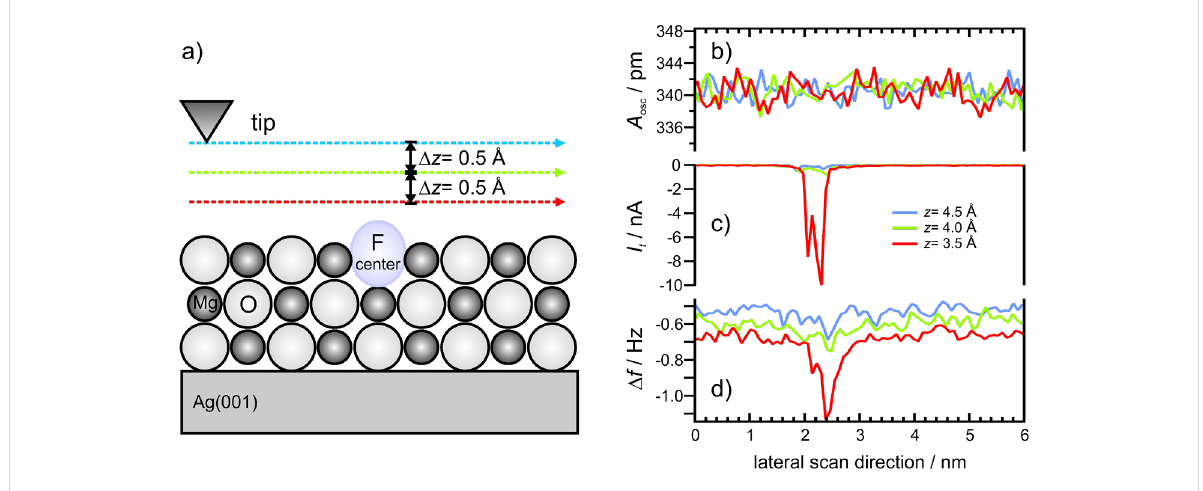
Figure 7: Dependence on tip-sample distance. Constant height line-scans across an F 0 defect situated at a step edge. The scan direction is along the step edge. The three presented channels have been measured simultaneously. The colors indicate different tip-sample distances. Note that the dis- placement of 4.5 Å has been chosen arbitrarily, since absolute values are generally unknown in scanning probe microscopy. b) The oscillation ampli- tude is constant during scan process. This excludes artefacts in frequency shift. c) The tunneling current and d) the frequency shift. Data were obtained at a bias voltage of U bias = − 50